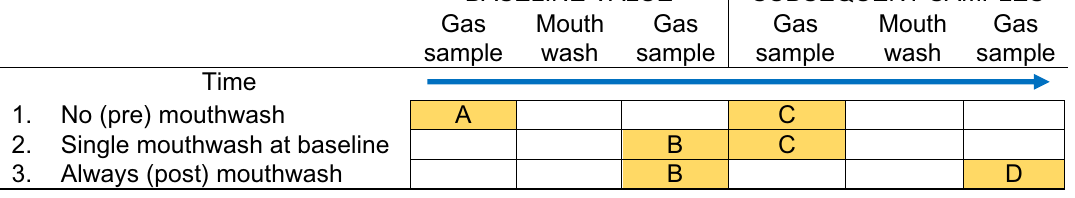
Table 2. Graphical presentation of study protocol and data analysis.